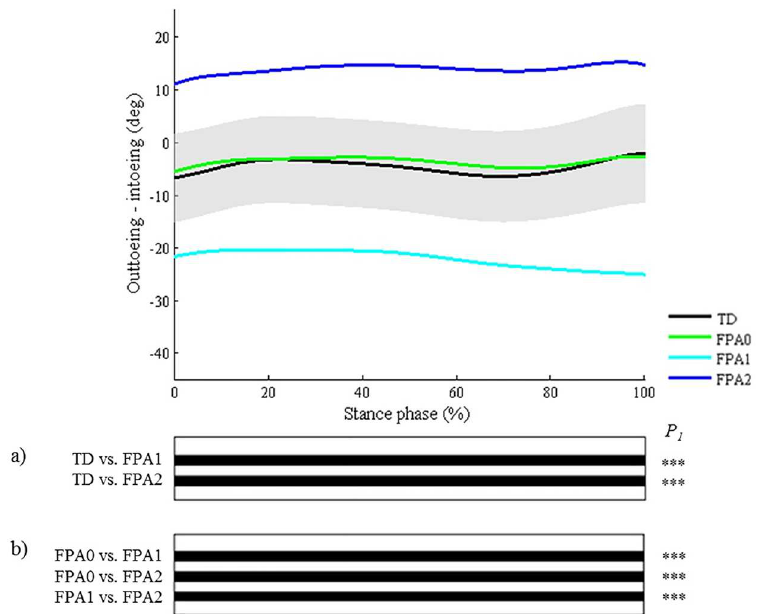
Fig 3. Foot progression angle (FPA). Top graph shows the mean kinematic angle of TD gait and of each consensus-based pattern of the foot progression angle. Black bars indicate significantgait phases during which the SPM{t} statistic exceededthe critical threshold. Panel ( a ) shows results of hypothesis2 (i.e. unpairedt-tests, α = 0.01); panel ( b ) shows results of hypothesis3 (i.e. post-hoc unpairedt-tests, α = 0.003). * p < 0.01, ** p < 0.001, *** p < 0.00001.P 1 indicatesthe p-value of the first cluster duringthe stance phase.